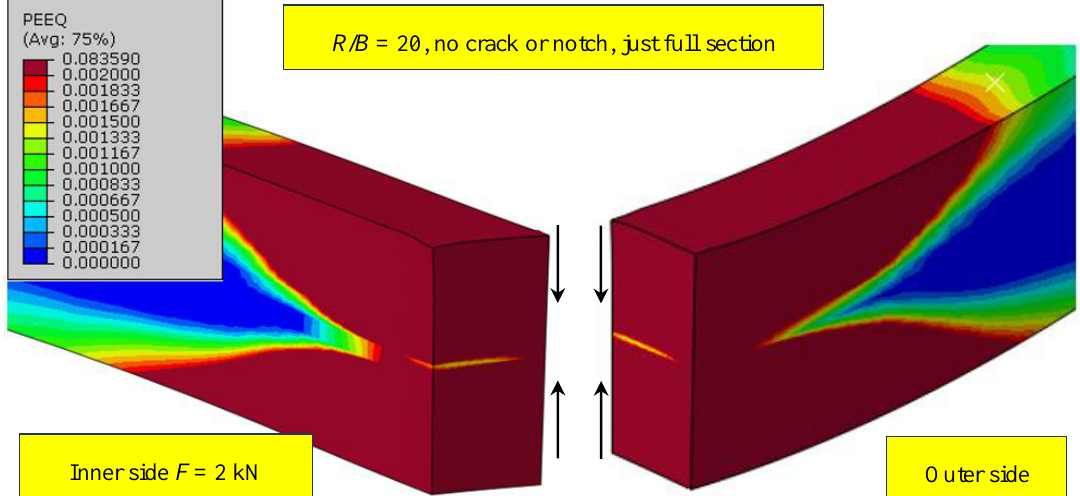
Figure 7. The equivalent deformation, where a small layer of the neutral zone still remains undeformed at 10 mm displacement. While spreading of the deformation over the upper and lower periphery of ring stopped, it now started extending into the interior.